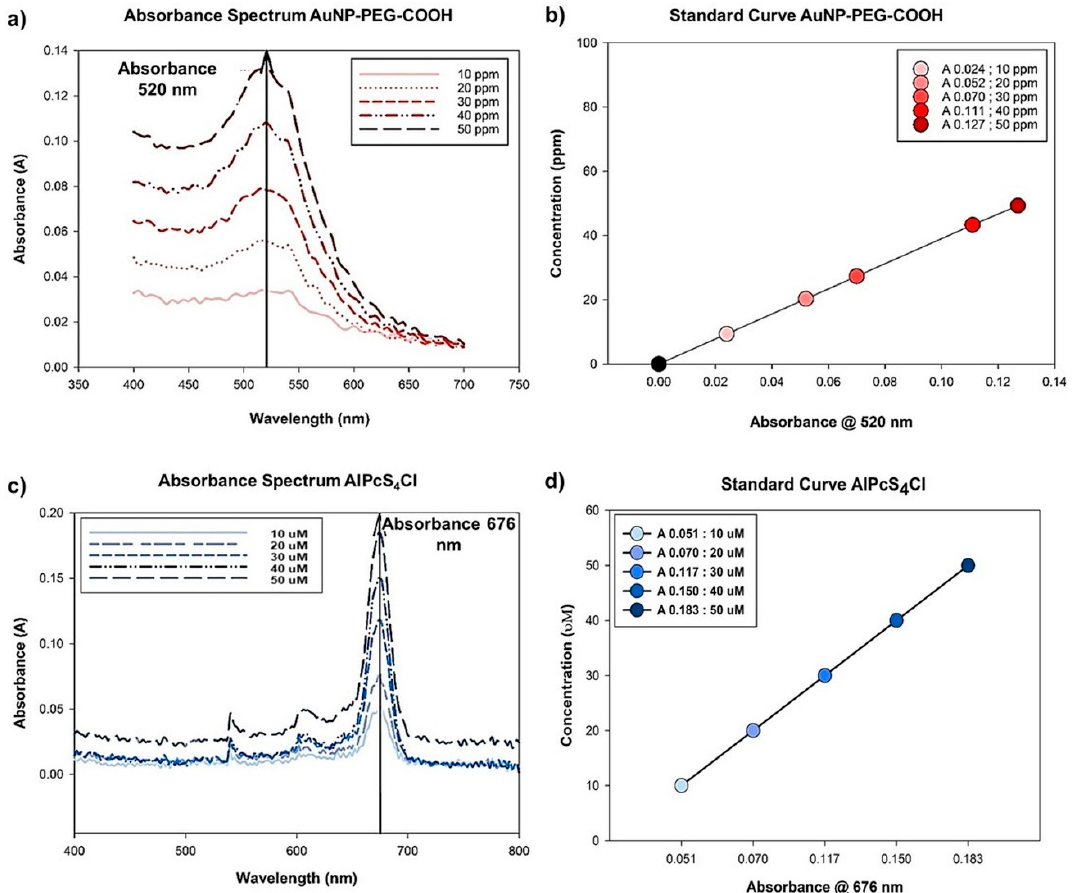
Figure 3. ( a ) Absorbance spectra of AuNP-PEG-COOH, showing an absorbance peak at 520 nm. ( b ) Standard curve of PEG-AuNP-COOH concentrations (10–50 ppm). ( c ) Absorbance spectra of AlPcS 4 Cl, showing an absorbance peak at 676 nm. ( d ) Standard curve of AlPcS 4 Cl concentrations (10–